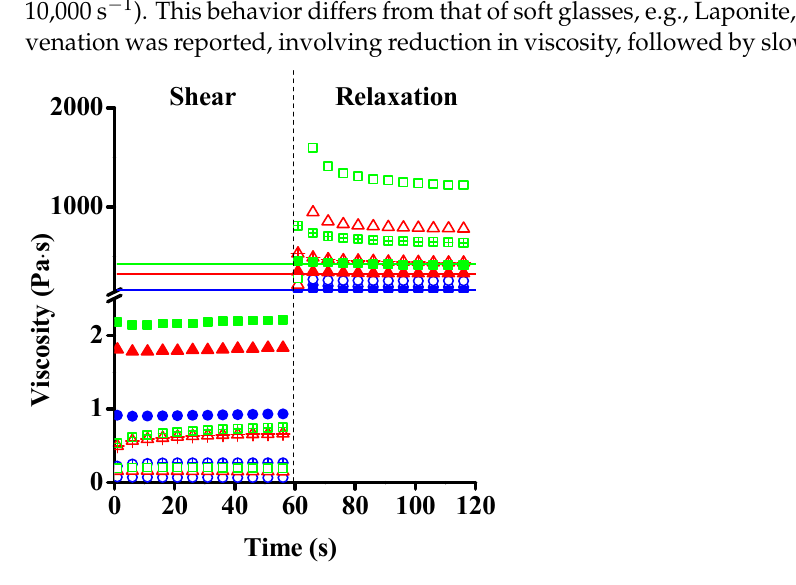
Figure 11. Relaxation process of aqueous GO suspensions of different ages. 0 y—blue dots; 1 y—red triangles; 2 y—green squares.